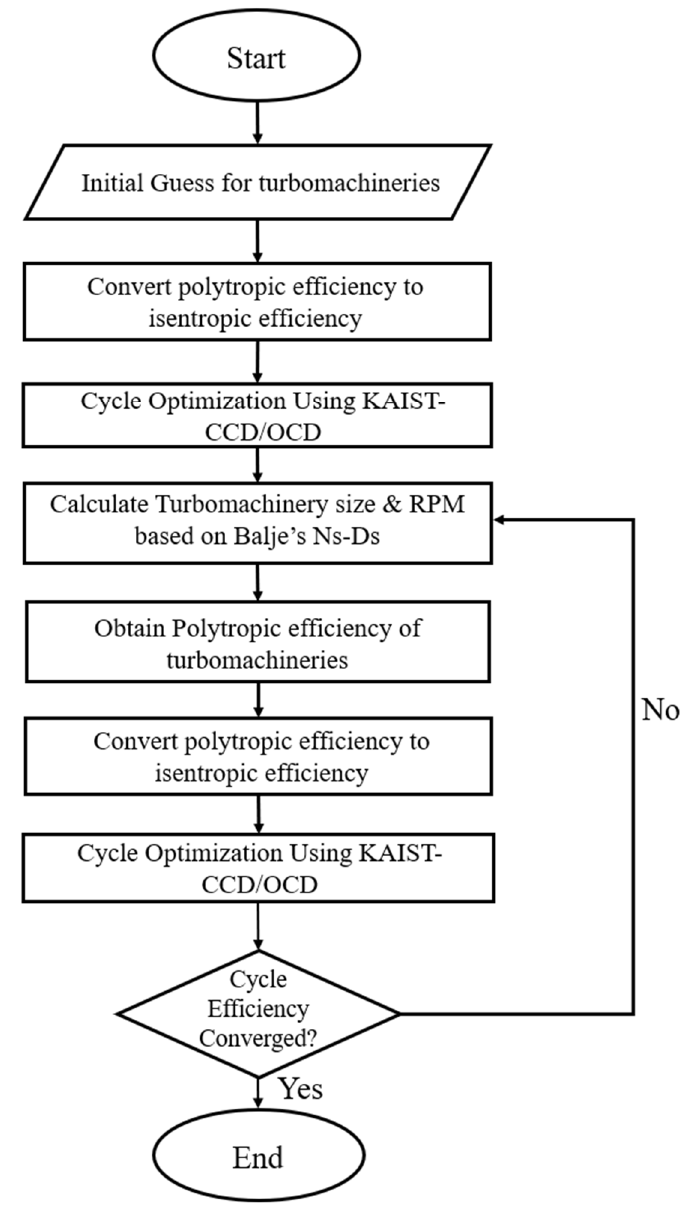
Figure 13. Flowchart for the cycle optimization.